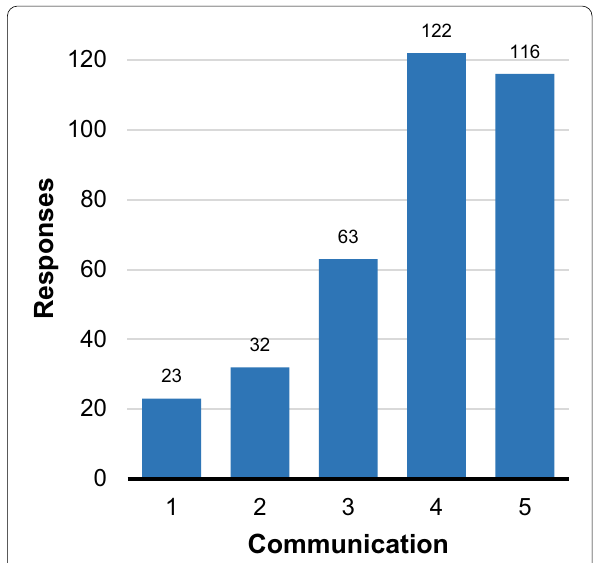
Fig. 8 Satisfaction of respondents with the communication of results (1 very unsatisfied, 5 =